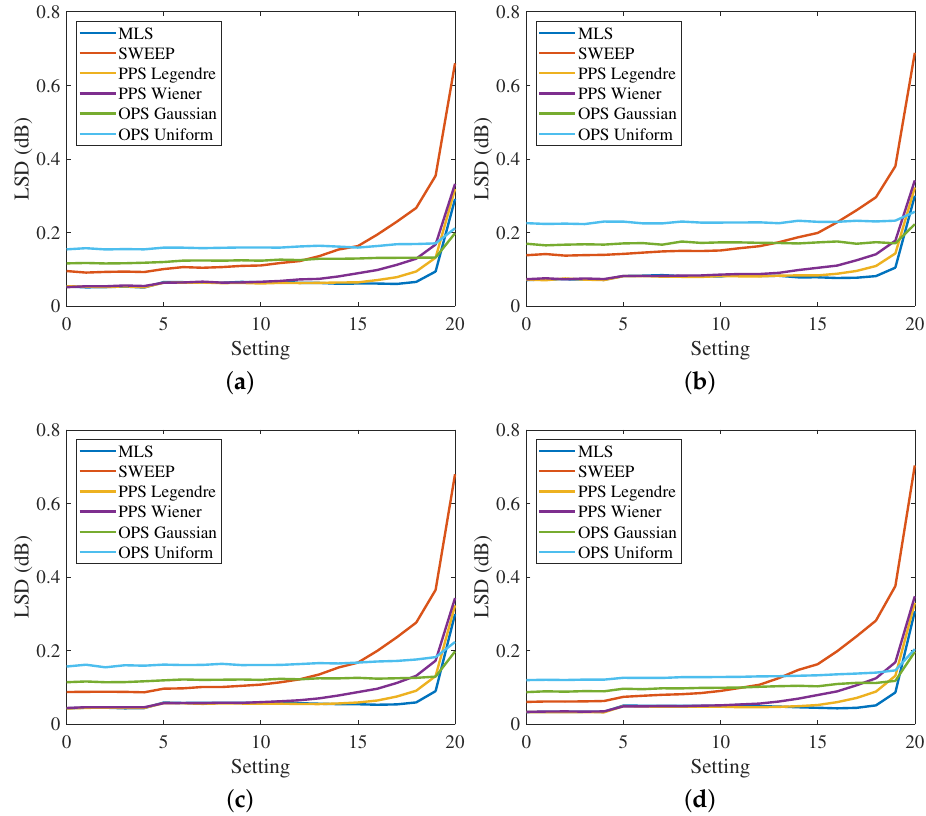
Figure 13. Log-spectral distance in the band [100, 18000] Hz at the different settings with the Electro Harmonix East River Drive pedal for ( a ) the response of the left ear from the left speakers, ( b ) the response of the left ear from the right speakers, ( c ) the response of the right ear from the left speakers, and ( d ) the response of the right ear from the right speakers with a 40 dB output